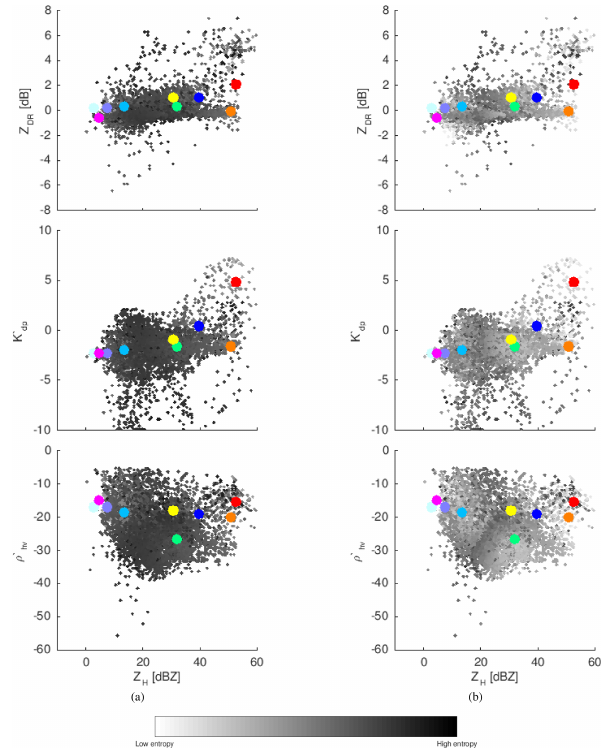
Figure 7. The multi-dimensional (four out of five dimensions) space, with target vectors representing centroids (larger points with different classes depicted by different colors) and observations with the level of gray depicting (a) Shannon version of the entropy from Besic et al. (2016) and (b) parametrized